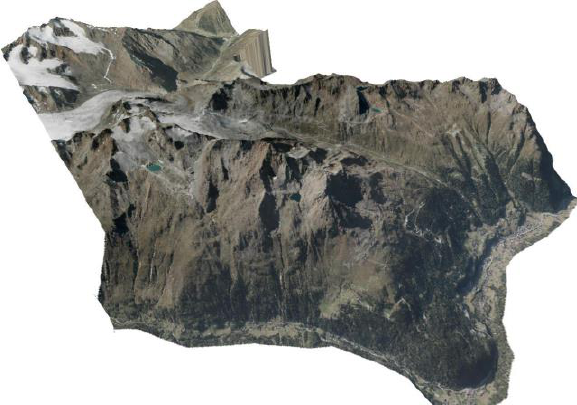
Figure 12. Perspective overview of the mission areas (2015 foreground, 2014 background), view direction